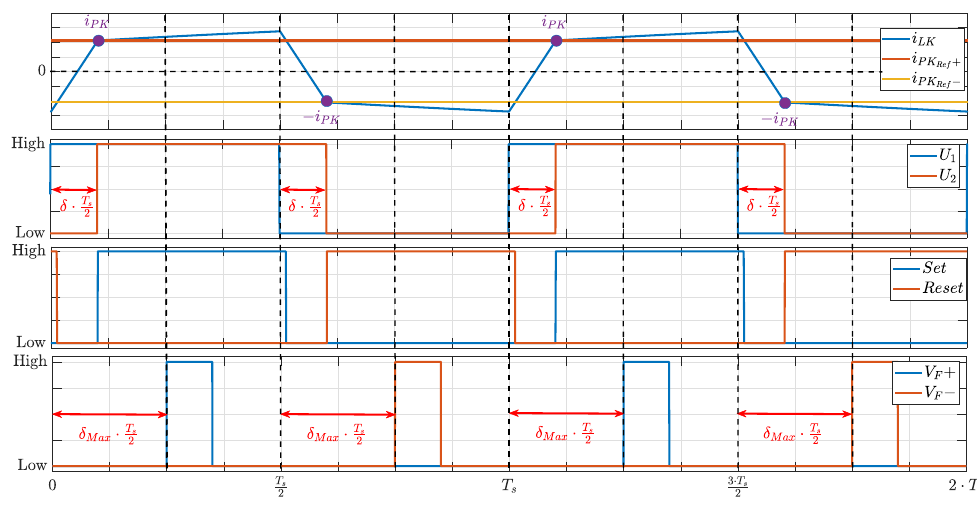
Figure 7. Changes in U 2 due to i LK reaching the hysteresis band.